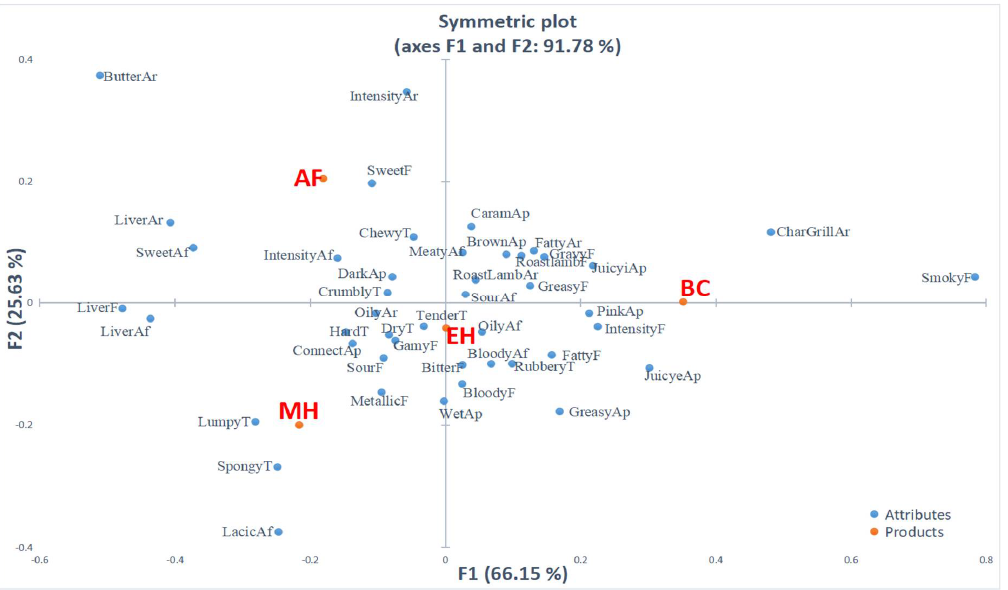
Figure 1. Correspondence analysis of CATA frequencies containing the attributes related to aroma (Ar), appearance (Ap), flavor (F), texture (T), and aftertaste (Af) that significantly differentiated for Gen Z consumers samples (according to the Cochran’s Q test at 95% significance level). The properties of the four groups were well separated (distance between the samples is a measure of their similarity [49]): BC, located at positive values of the first and second dimension; AF, located at negative values of the first dimension but positive values of the second dimension; EH, located at positive values of the first dimension but negative val- ues of the second dimension; and MH located at negative values of the first and second dimensions. Gen Z consumers associated BC with char grilled aroma and smoky flavor, while they associated AF with buttery aroma and intensity aroma. Similarly, Gen Z con- sumers associated EH with dry texture and gamy flavor while MH was associated with light color external appearance. 3.3. Important Variables The machine learning methods deep neural network, gradient boosted trees, support vector machine, and orthogonal matching pursuit—stochastic gradient descent were ap- plied to identify the consumer preferences of lamb shashliks of different types as a func- tion of the sensory attributes and evaluated the degree of association between products and attributes present in the perception map. The machine learning methods according to Cochran’s Q test were performed using only the attributes that distinguish samples. Of the classification accuracy and regression of machine learning algorithms for pre- dicting overall preferences, DNN is the highest (0.983 and 0.966), OMP-SGD is the second (0.929 and 0.913), and SVM and GDBT are the last. Table 4 shows the overall preference for each cooking method under each machine learning algorithm. Figure 2 shows that all algorithms are in good agreement with experimental data considering the training set, test